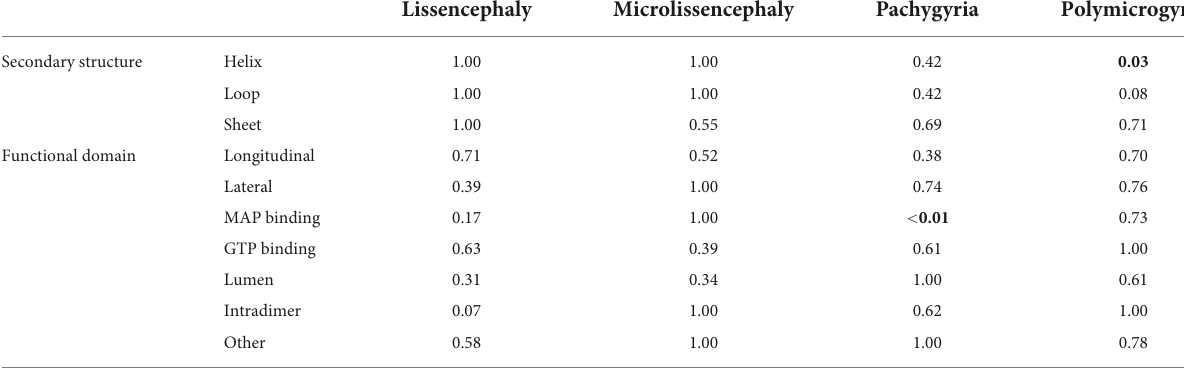
TABLE 1 Fisher’s exact tests were performed to determine whether the associations between cortical malformation mutants and either secondary structures or functional domains are non-random. Lissencephaly Microlissencephaly Pachygyria